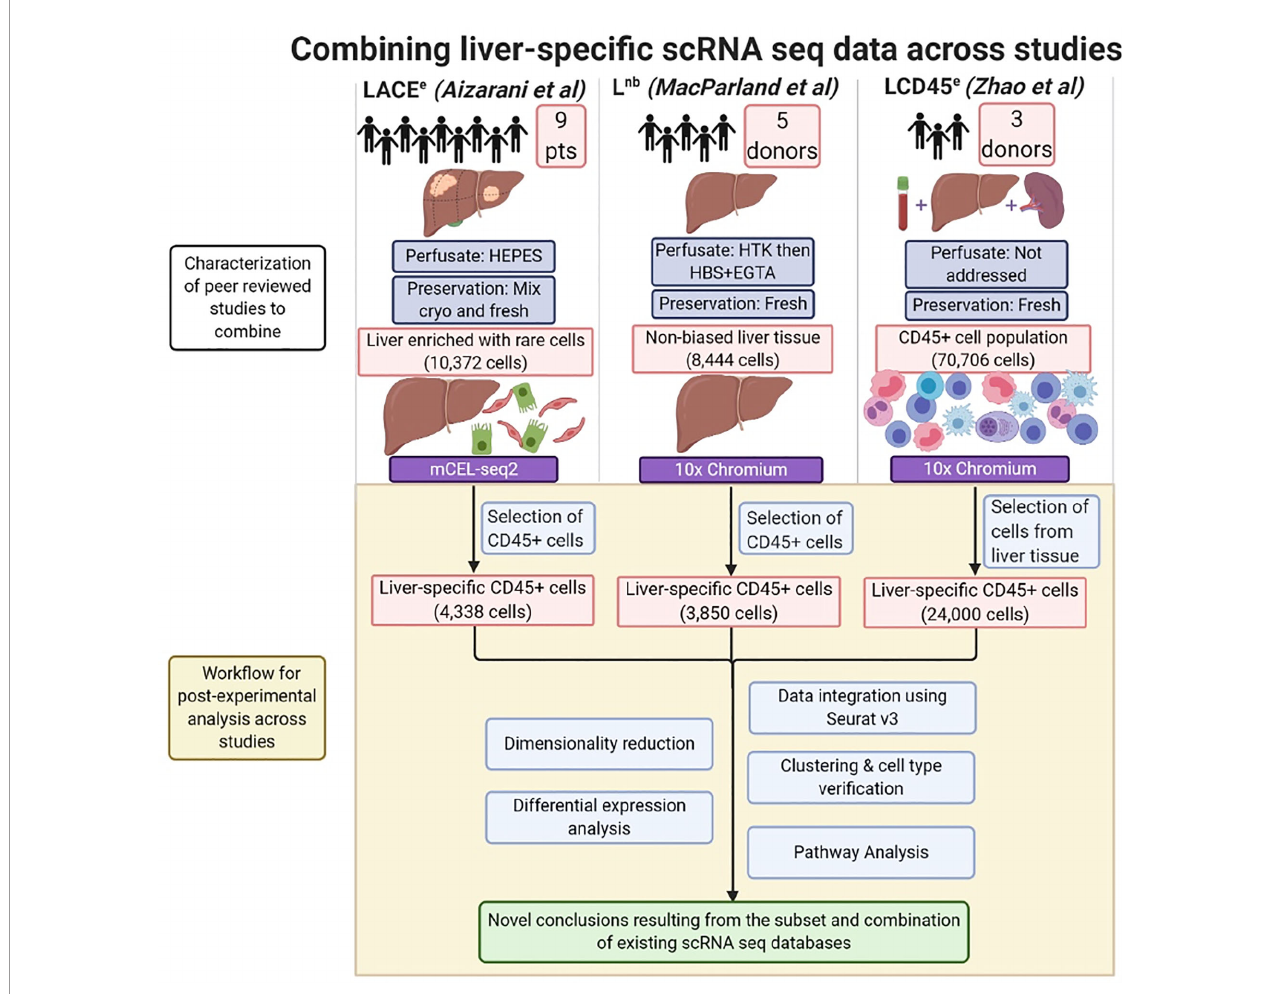
FIGURE 1 | Combining liver-speci fi c scRNA seq data to create a human liver immune meta-atlas. Schematic diagram summarizing the number of subjects and major pre-analytical variables pertaining to scRNA sequencing of human liver. Post-experimental analysis performed in this study is highlighted in the shaded region. CD45+ cells were selected from the LACE e and L nb studies. CD45+ cells (which were already pre-selected for in the LCD45 e dataset) which were of liver origin were post-experimentally extracted as splenic and peripheral blood cells were also included in the original dataset. The scRNA seq analysis pipeline (Seurat v3 in R) was applied, then clustering and differential expression analysis were used to assess the ability to combine scRNA seq techniques and generate datasets for tertiary pathway analysis of immune function in the normal human liver. Created with